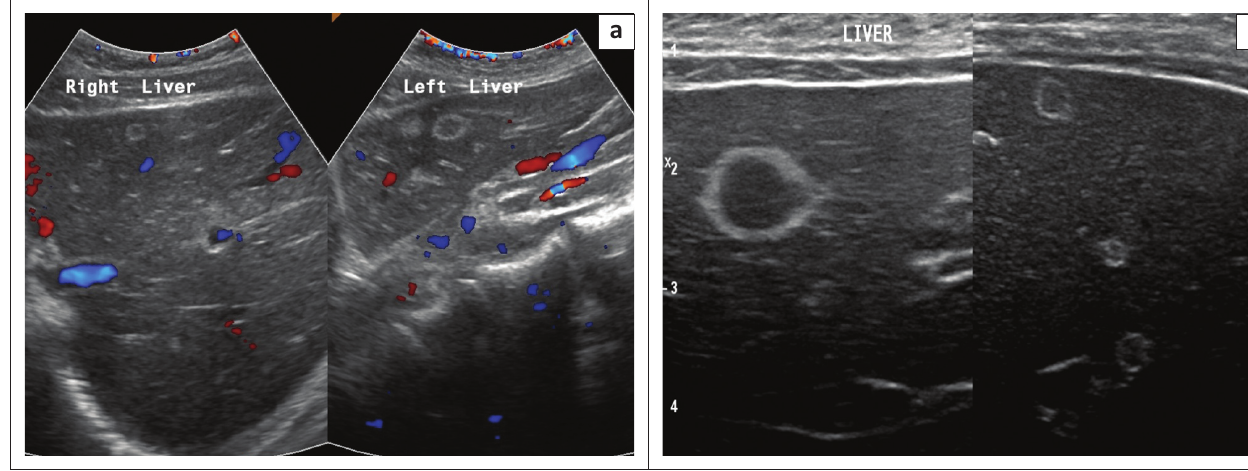
FIGURE 2: Sonar image of the liver: (a) in colour duplex; (b) in B-mode higher frequency.